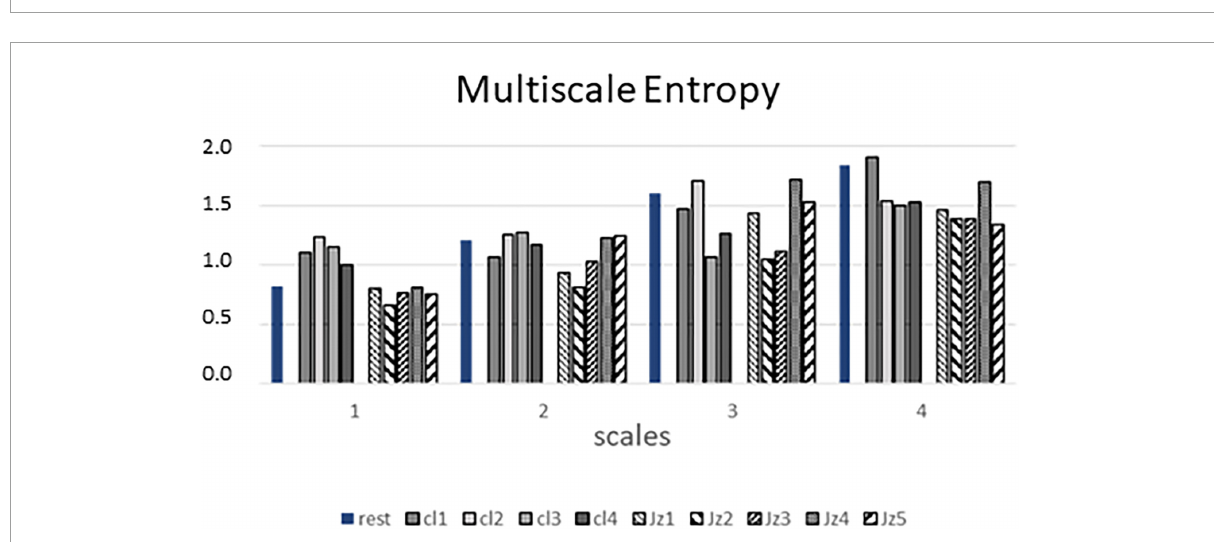
FIGURE2 Figure shows the results of the Multi Sample Entropy analysis for the first 4 scale factors relative to the basal period (rest, blue bars), the 4 classical pieces (cl1-cl4, grey bars) and the 5 jazz pieces (jz1-jz5, striped